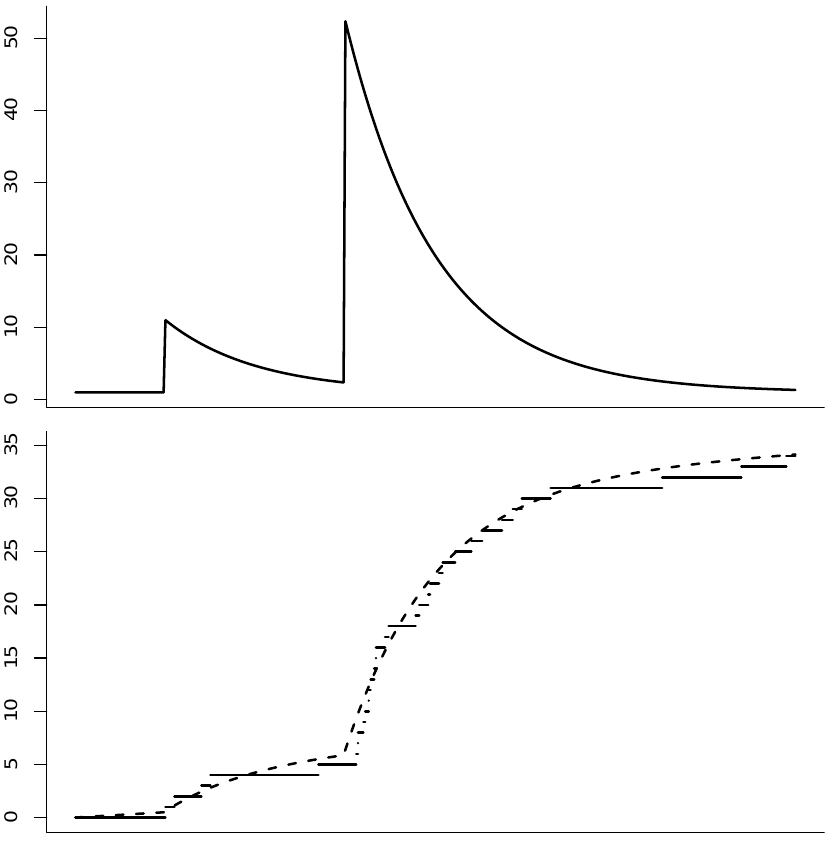
Figure 1. Illustration of a shot-noise process ( Top ) with exponential structure. The graph on the bottom shows a counting process whose jump times have the shot-noise process as intensity (cid:96) . The dashed line is the cumulated intensity process L ( t )